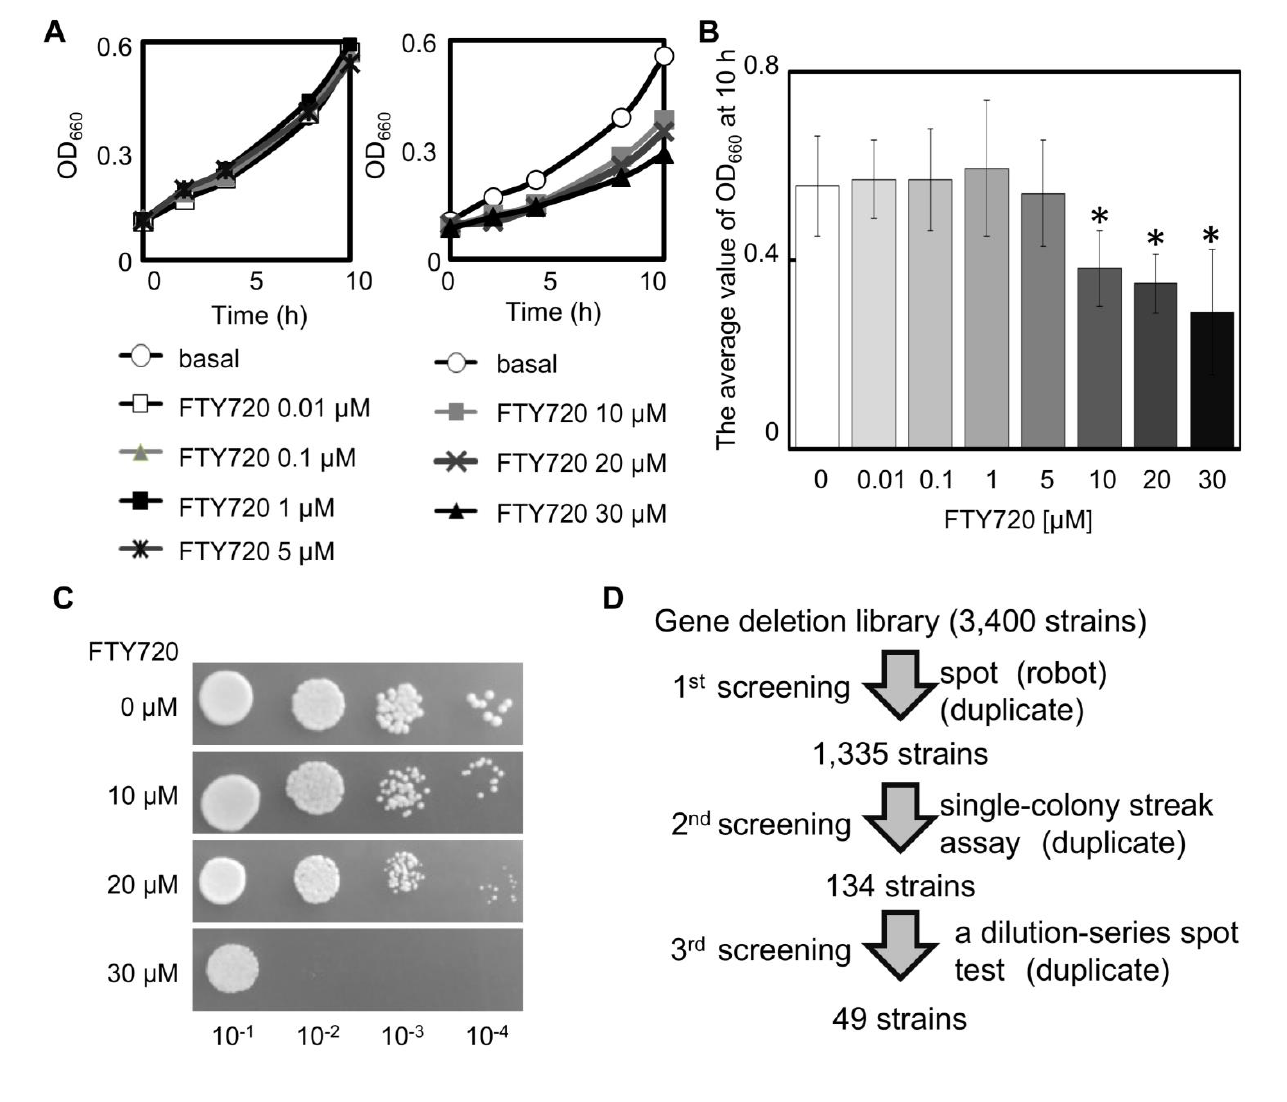
FIGURE 1: Fission yeast cells are sensitive to FTY720. (A) Quantitative measurements of cell growth in the presence of FTY720. The wt strain (KP178) was grown in liquid YES cultures to an OD 660 of 0.3 and was treated with FTY720 with the concentrations indicated, and the quantitative measurements of cell growth rates were performed using a microplate reader (SunriseTM series, Tecan, Switzerland). The growth curves of the cells presented are the average for three independent curves. (B) The histograms show the OD 660 at 10 h, as indicated in Figure 1A. The data were averaged from three independent experiments. Error bars, SD, *P < 0.05, significantly different from FTY720 0 µM using Williams’ test. (C) A serial dilution assay of the wt strain grown in YES medium or YES medium containing the indicated concentrations of FTY720. Cells were incu- bated for 4 days at 27°C. (D) Work-flow of the screening procedure to uncover genes required for FTY720-resistance. A total of 3,400 strains from Bioneer ver4.0 library were screened. Each of the strains was automatically spotted on YES media containing 0, 10, 20 µM FTY720 and serially diluted and manually streaked and subsequently spotted. 49 strains were found to be repeatedly showing sensitivity on